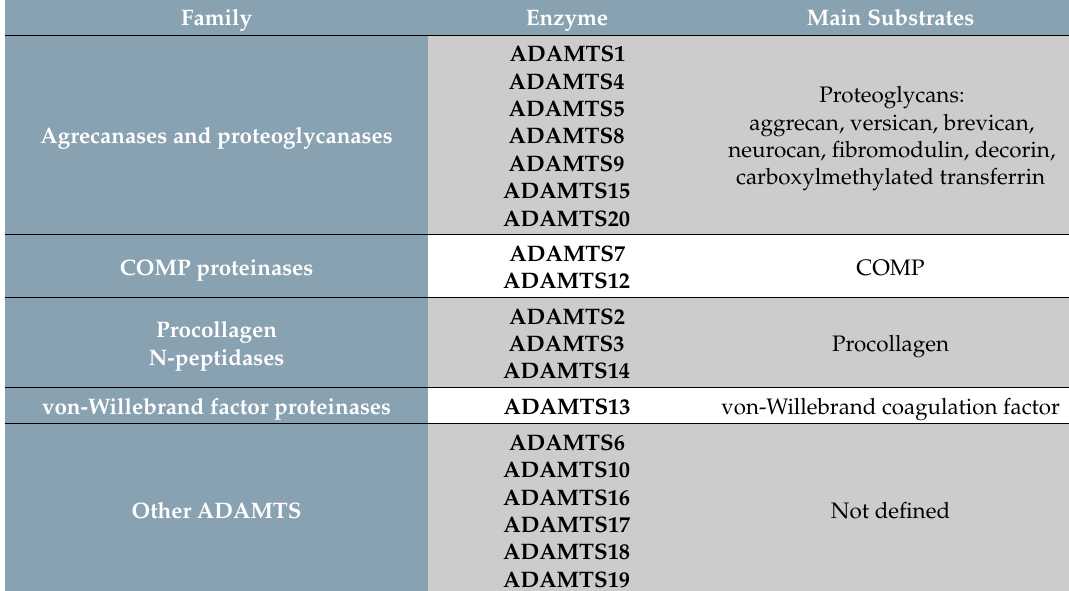
Table 2. Classification of human a disintegrin and metalloproteinase with thrombospondin motifs